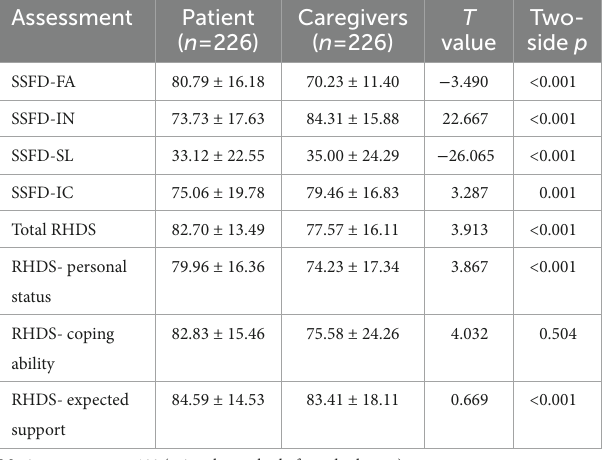
TABLE 1 Differences in AMI patients’ and caregivers’ perceived discharge readiness and family dynamic ( n =